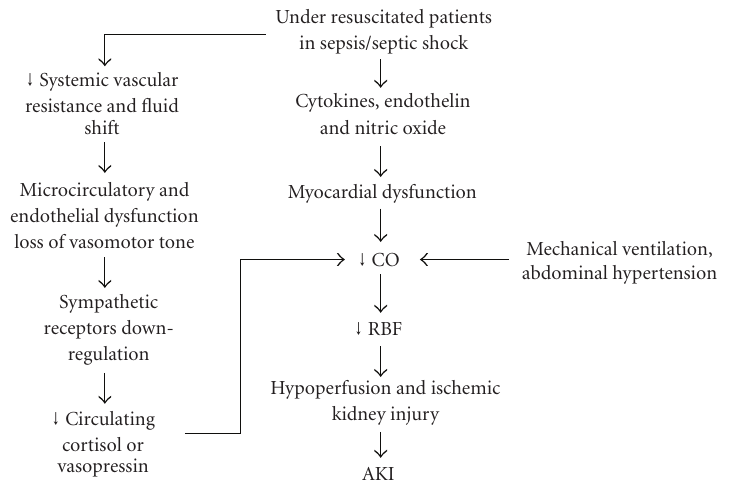
Figure 1: Hemodynamic alteration in underresuscitated sepsis patients (see text for